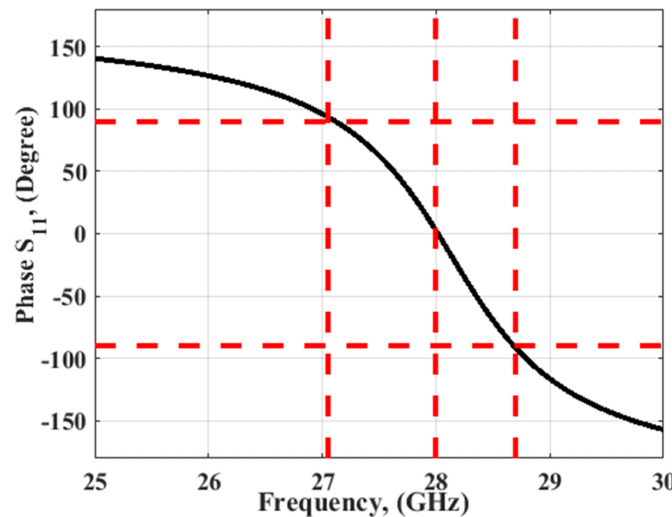
Figure 12. The phase of |S 11 | results of the proposed AMC unit cell.